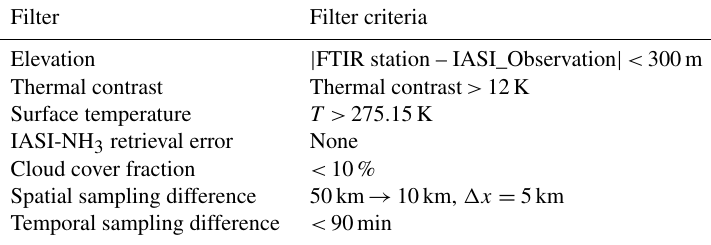
Table 2. Applied data filters to the IASI-NH 3